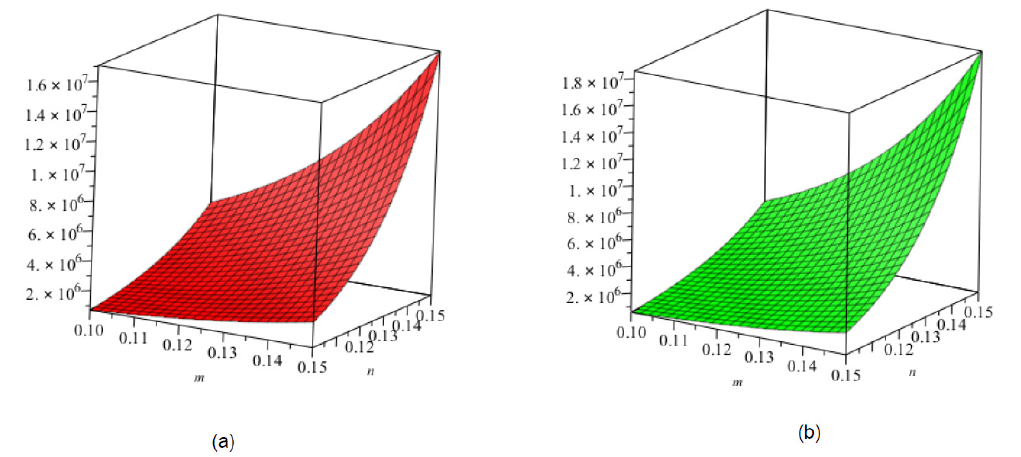
Figure 9 : (a) 1 st Zagreb coindex (b) 2 nd Zagreb coindex.